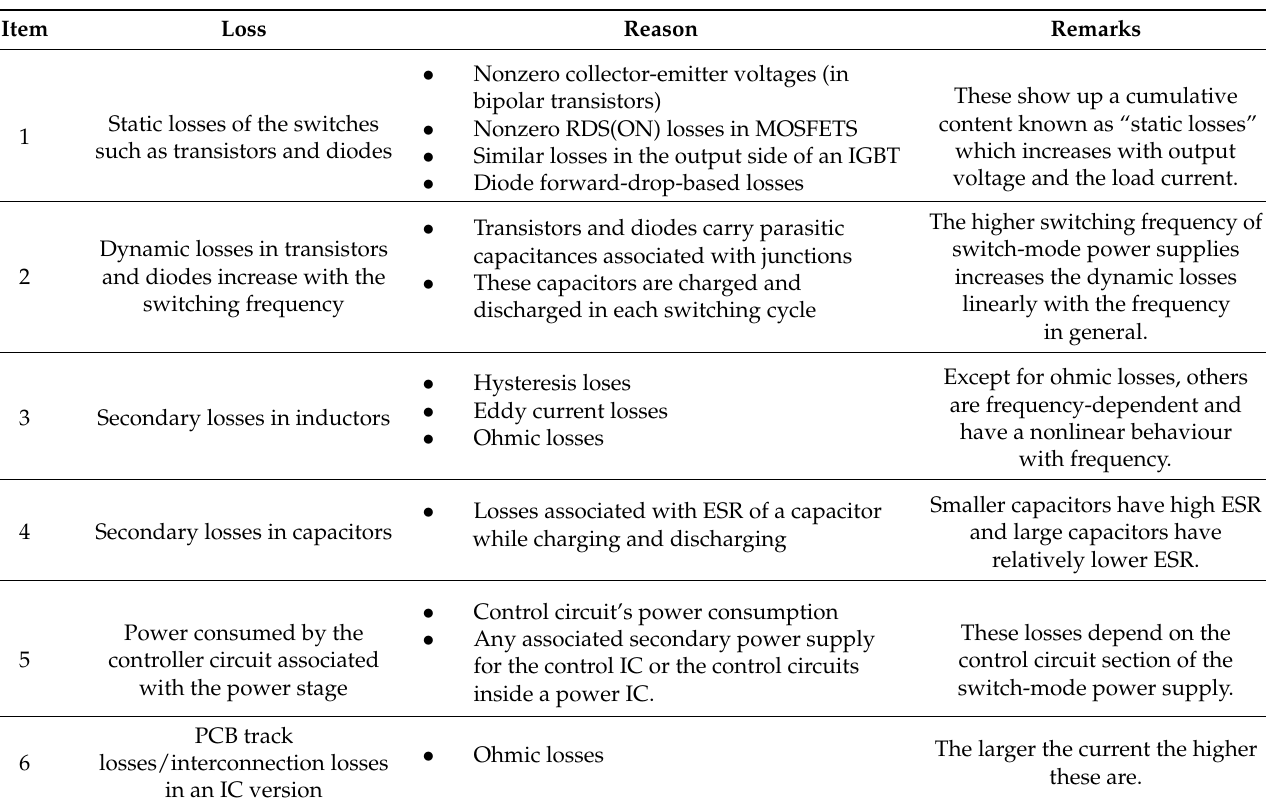
Table 4. Secondary losses of DC–DC